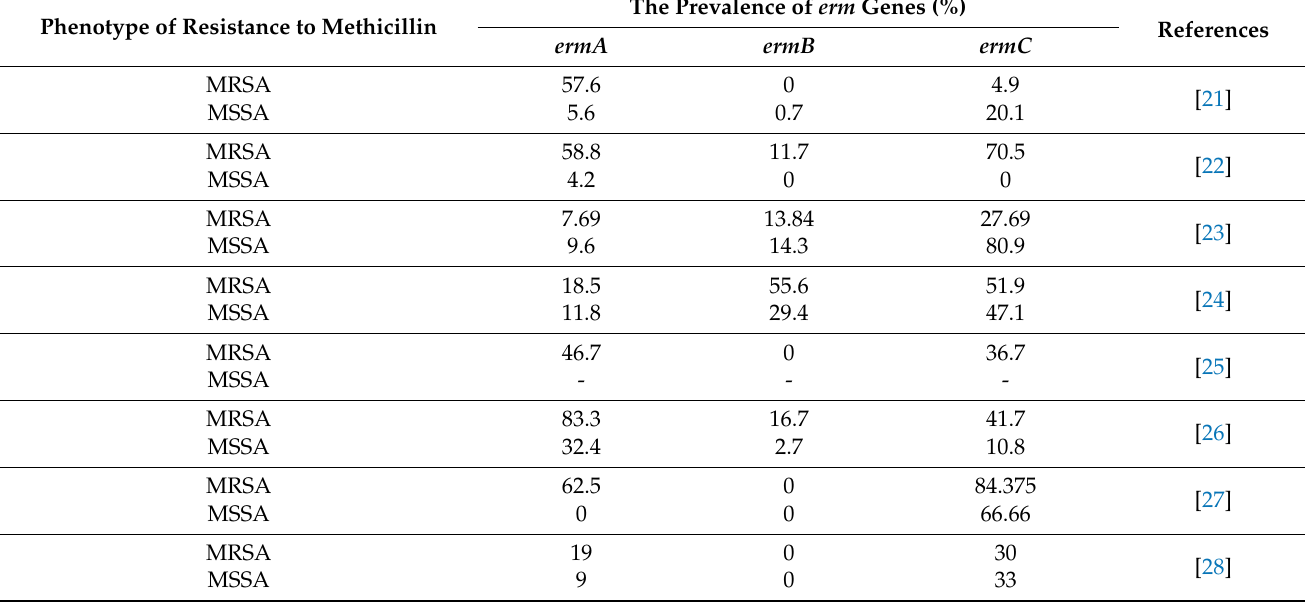
Table 2. Distribution of ermA , ermB , and ermC genes (%) among MRSA and MSSA strains [21–30,33,34,36,37]. Phenotype of Resistance to